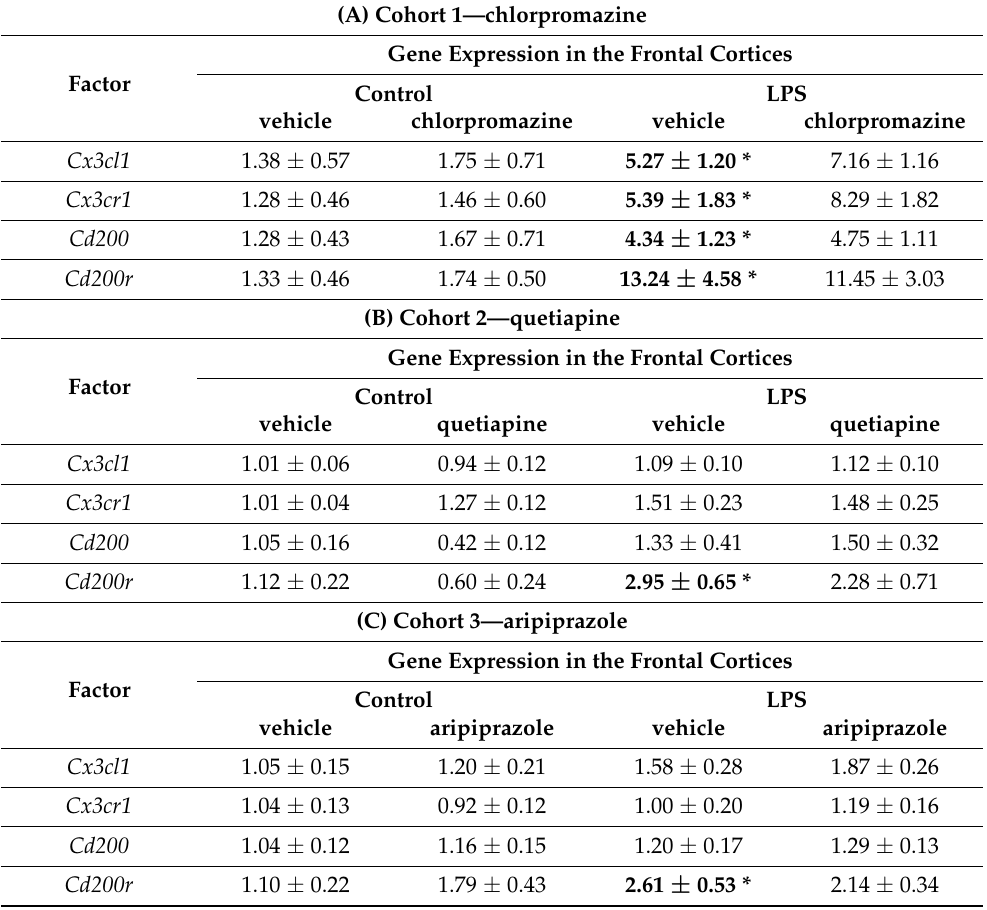
Table 2. The impact of prenatal exposure to LPS and subsequent chronic treatment with chlorpro- mazine ( A ), quetiapine ( B ) or aripiprazole ( C ) on Cx3cl1 , Cx3cr1 , Cd200 or Cd200r gene expression in the frontal cortices of the offspring. The mRNA levels were measured using qRT-PCR with n = 4–6 (chlorpromazine), n = 5–9 (quetiapine) and n = 5–6 (aripiprazole) in each group. The results are presented as the average fold change ± SEM. * p < 0.05 vs. control + vehicle